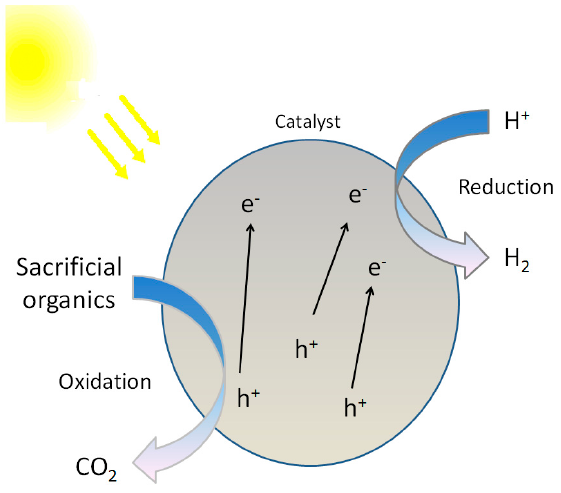
Figure 3. Photocatalytic reforming of organic species.